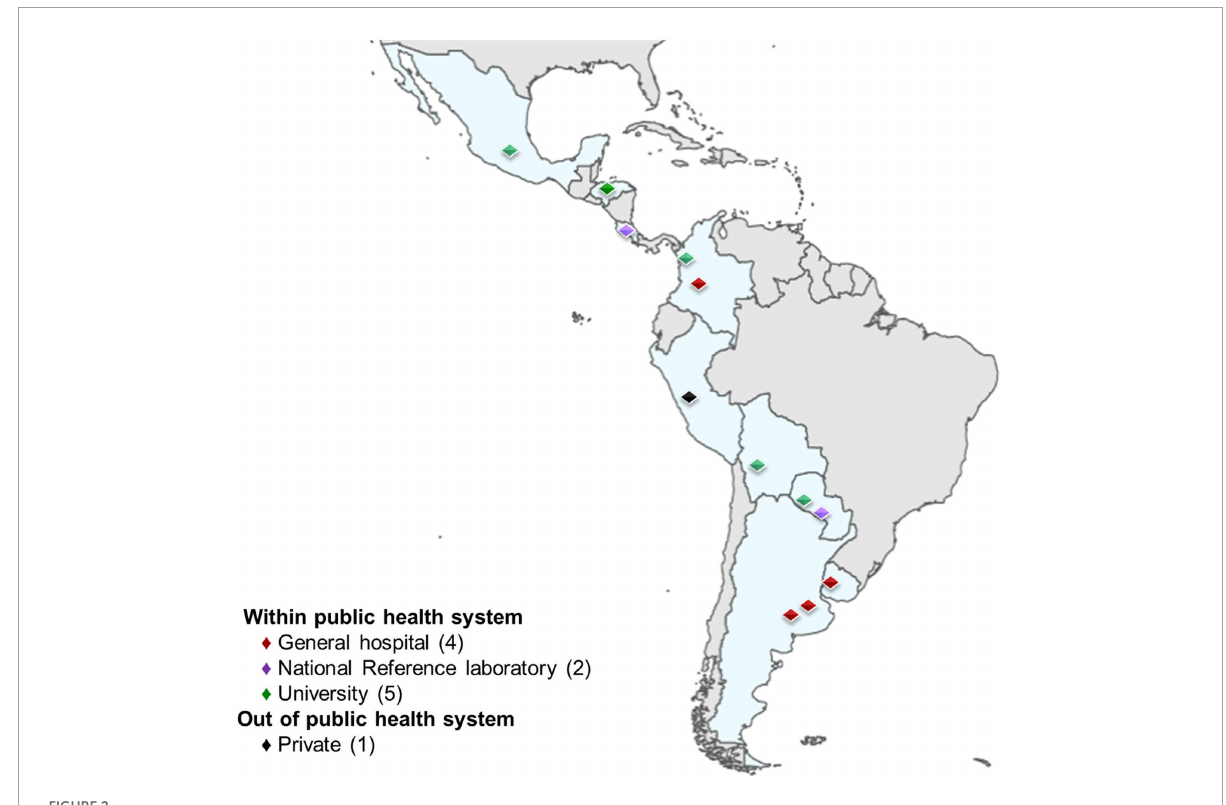
FIGURE2 Laboratory location and health system